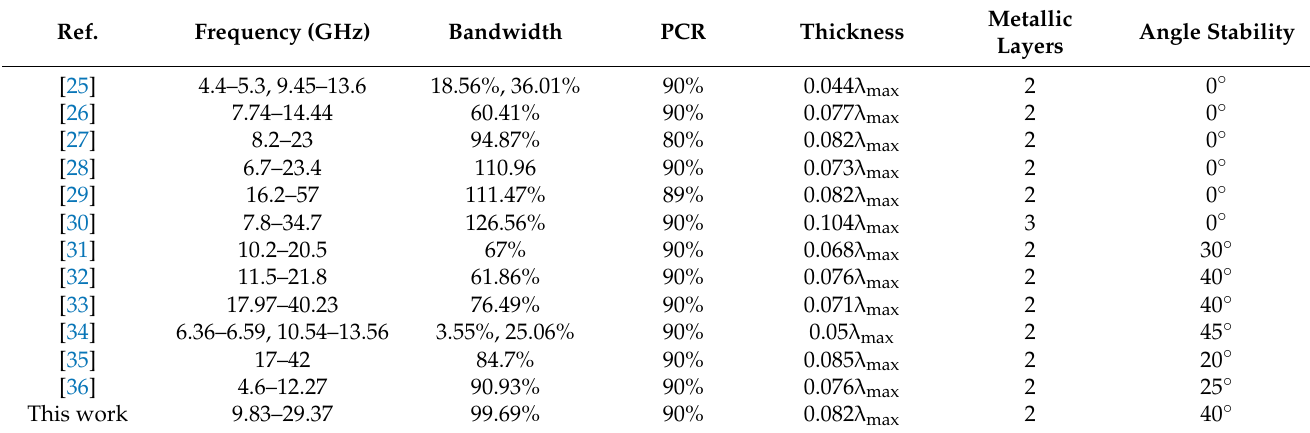
Table 1. Performance comparison of polarization